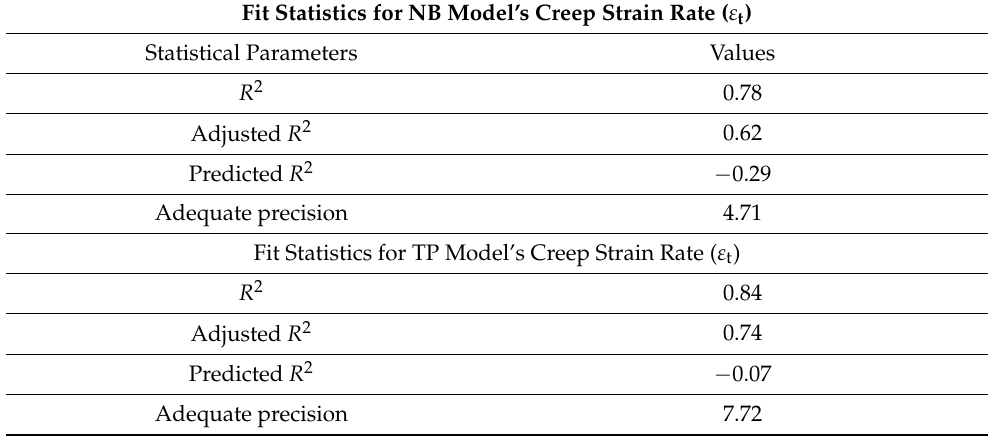
Table 6. Fit statistics of the